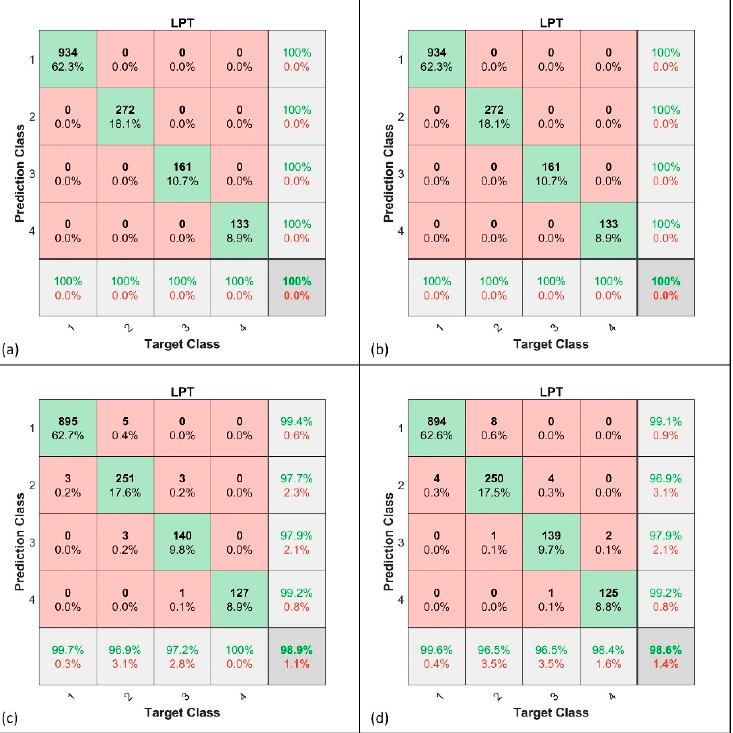
Figure 13. Confusion matrix for LPT. ( a ): Single-component FFNN; ( b ): single-component KPCA + FFNN; ( c ): multi-component FFNN; ( d ): multi-component KPCA + FFNN.